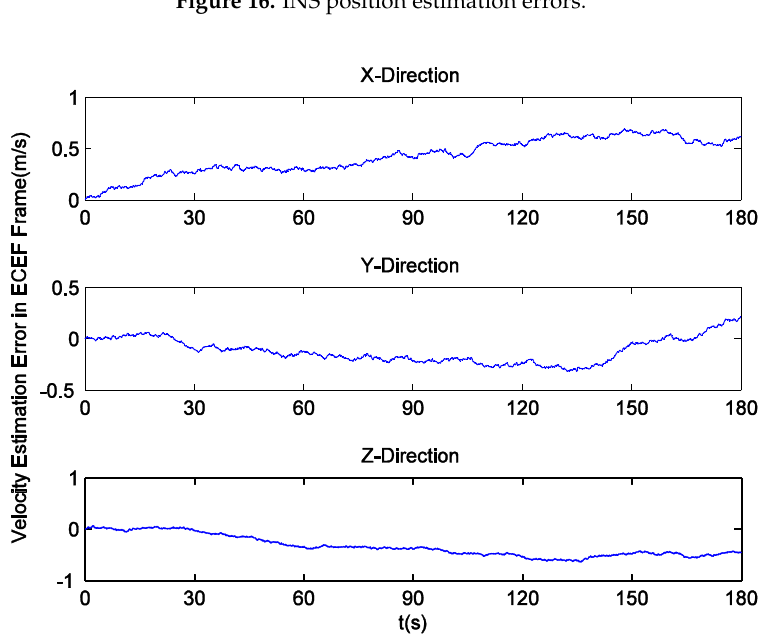
Figure 17. INS velocity estimation errors.